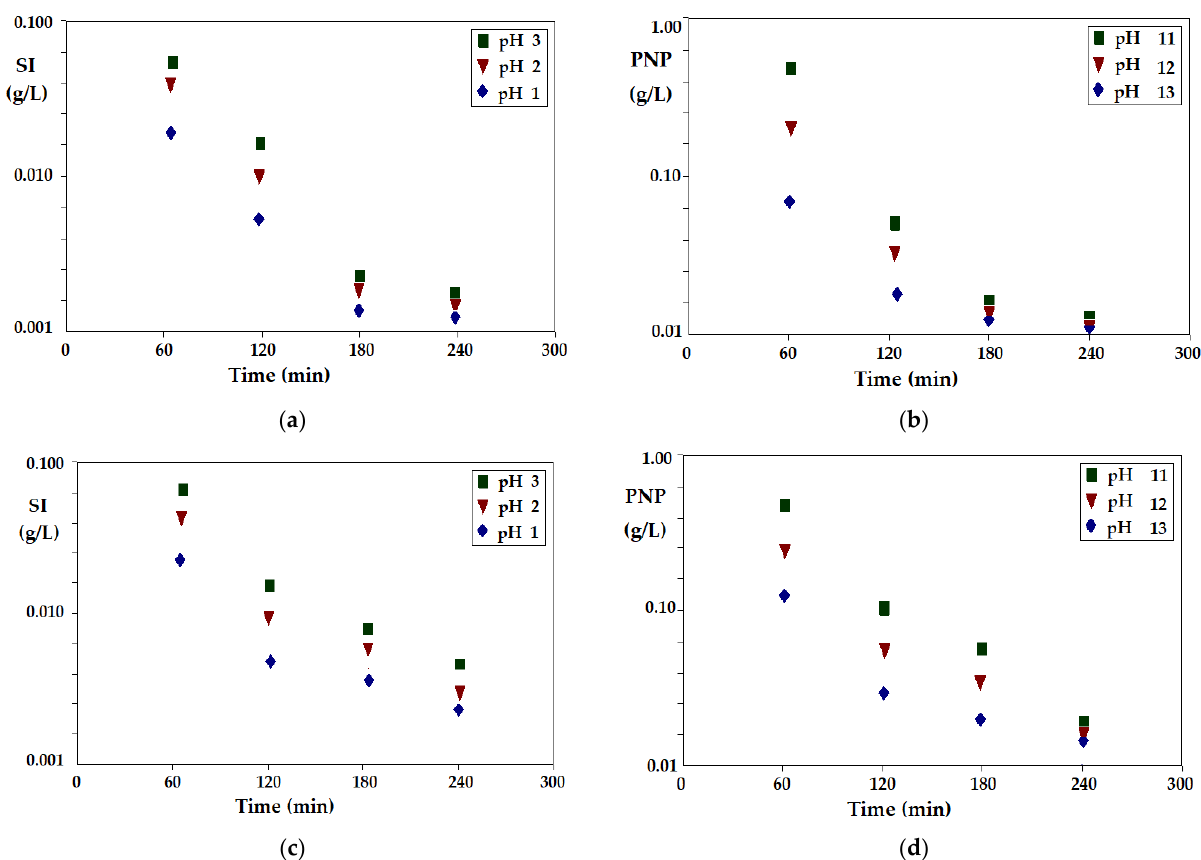
Figure 10. The decrease in the concentration of silver ions (SI) and p -nitrophenol (PNP), through an n -octanol membrane, depending on the pH of the receptor phase in the membrane phase, for a carrier of 10–undecenoic acid (UDAc), ( a ) and ( b ), respectively, and for carrier of 10–undecylenyl alcohol (UDA1), ( c ) and ( d ), respectively.